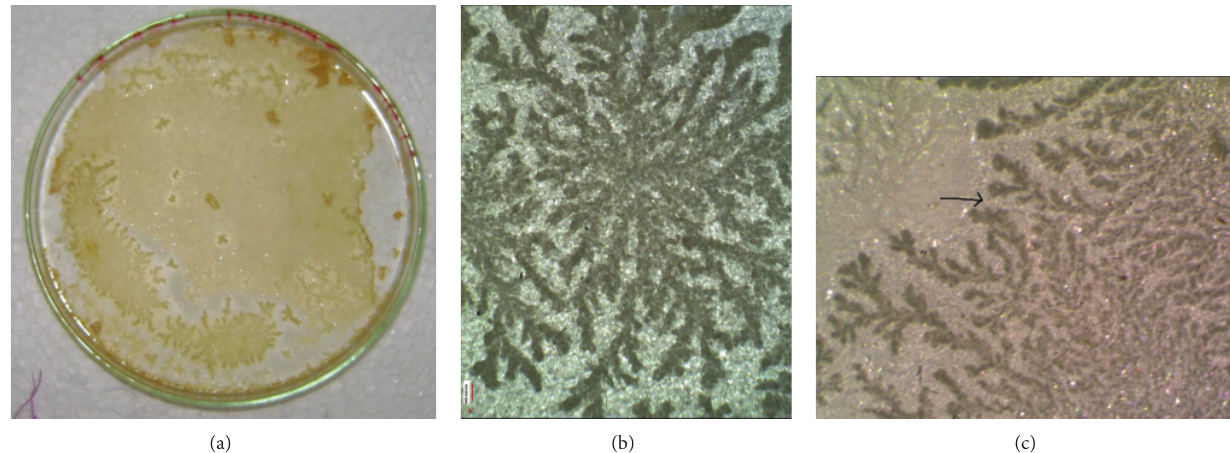
Figure 1: (a) Optical photograph of the fractal, (b) close view of the ramified structure, and (c) fractal pattern where tips are not touching each other.